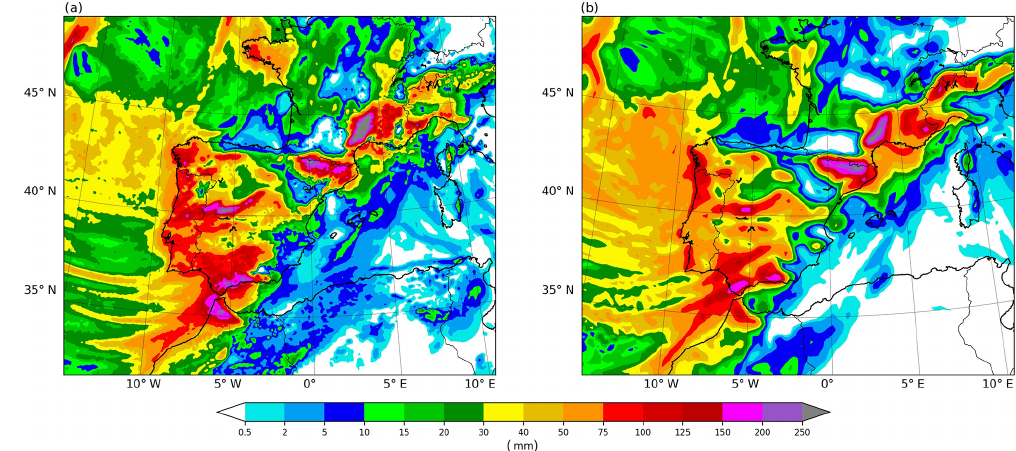
Figure 9. Similar to Fig. 4, but from 6 November at 06:00UTC to 9 November at